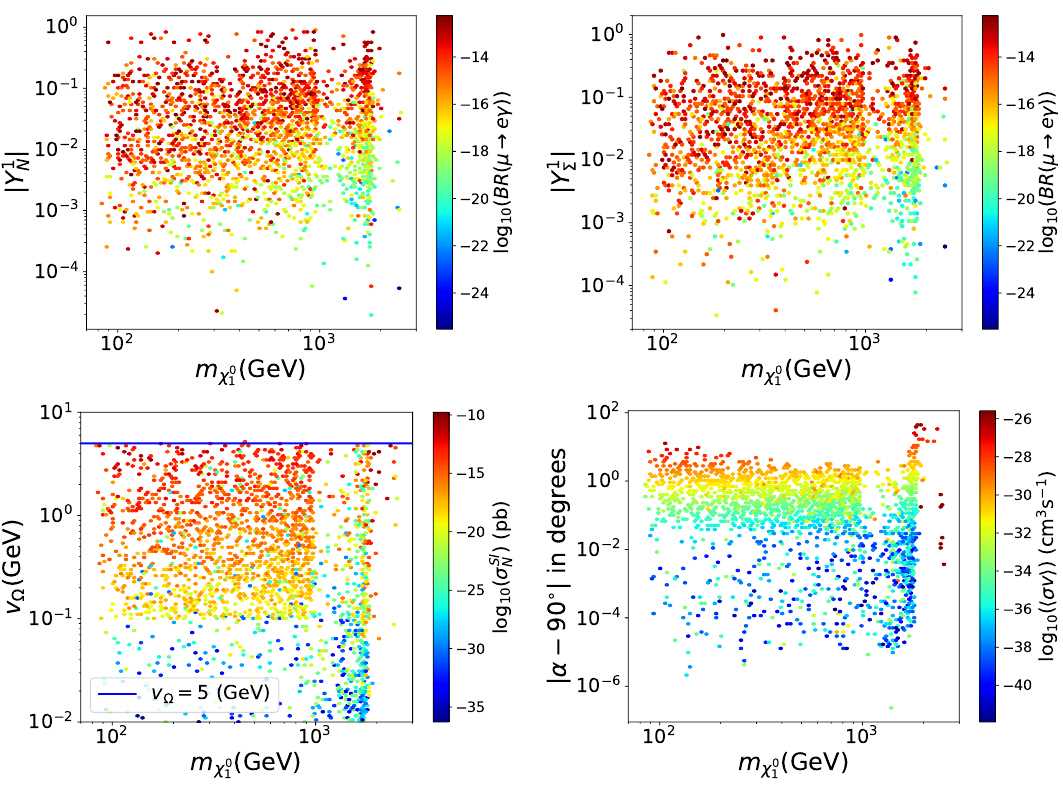
Figure 7 . Behavior of the parameters of the STFDM model that ful(cid:12)ll DM, neutrino physics and LFV